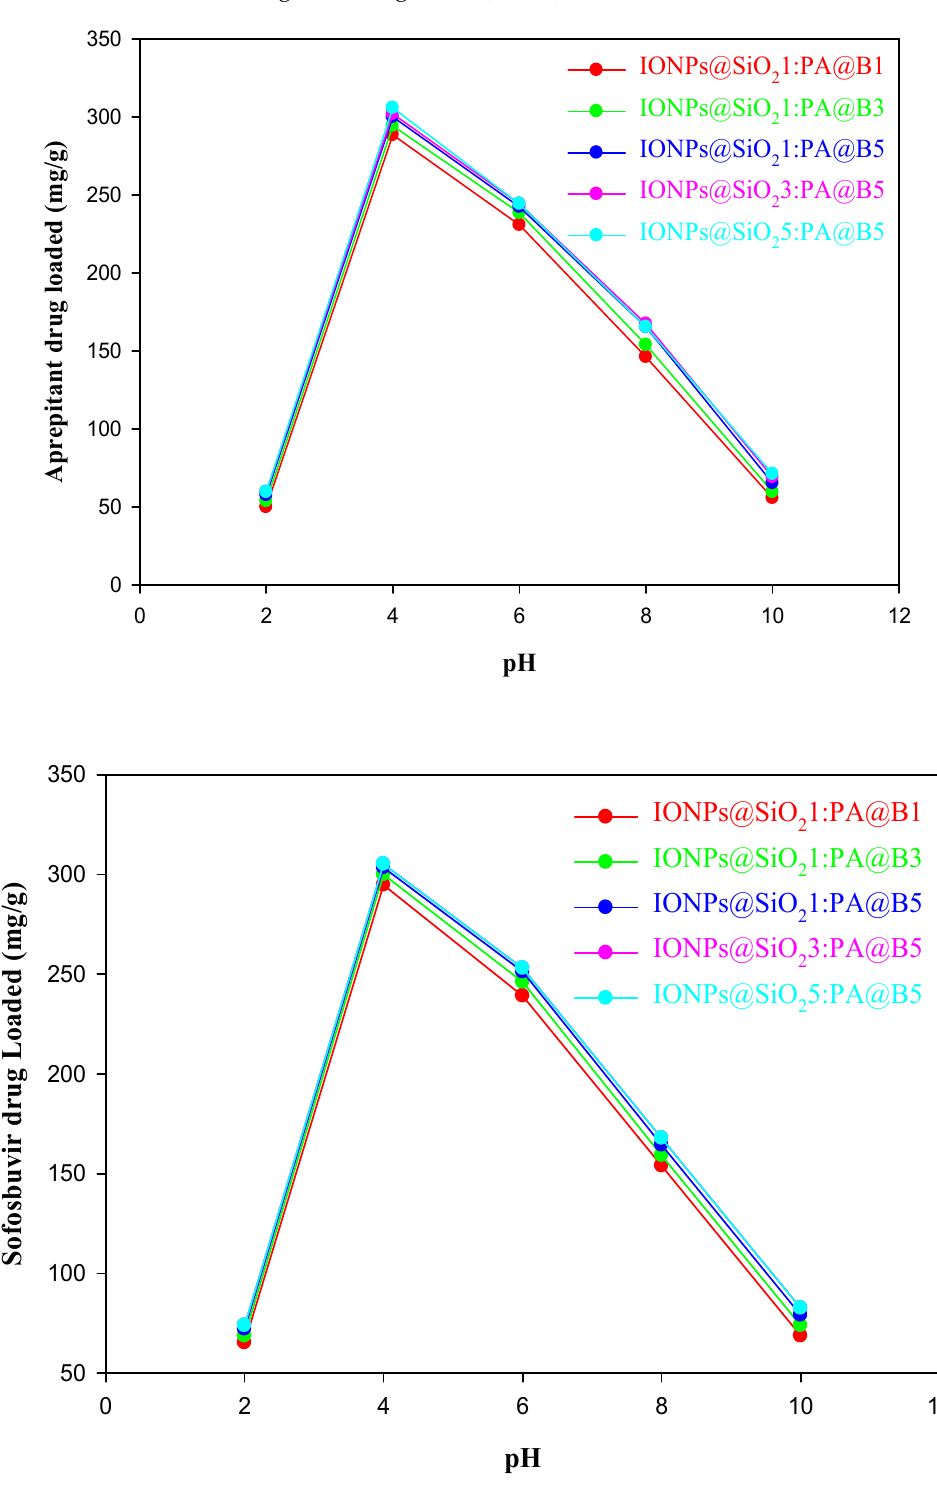
Figure 9. Loading of drugs into the fabricated MCM-PA@B at different pH values: aprepitant ( upper ); sofosbuvir ( lower ).